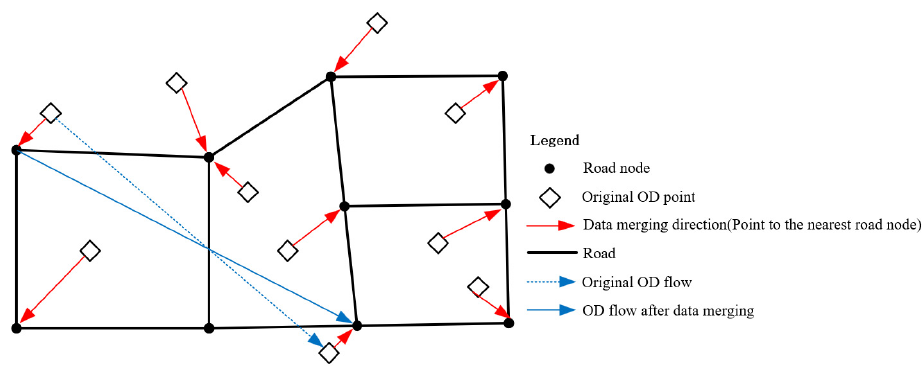
Figure 5. Merging of OD origin and destination with road nodes.